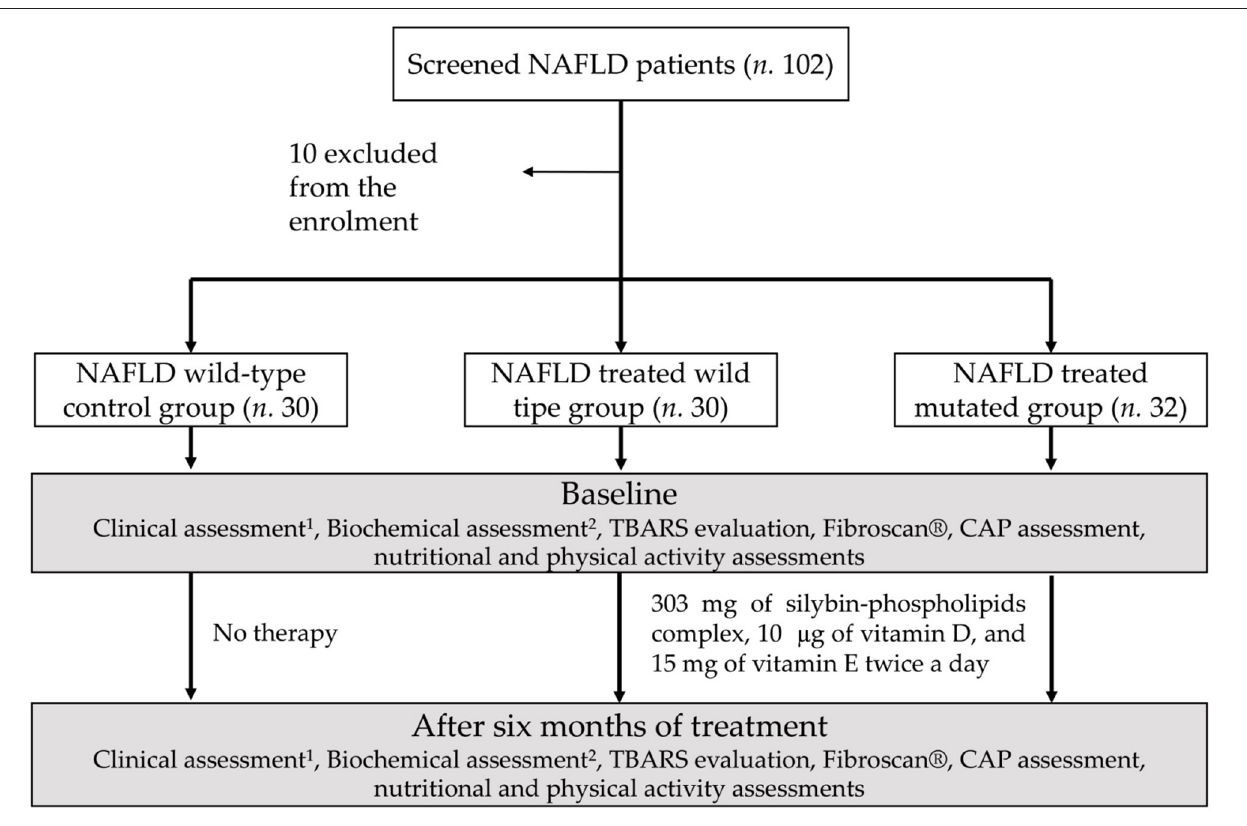
FIGURE 1 | Study design diagram flowchart: schematic representation of the experimental paradigm performed. 1 Weight, height, and waist-to-height ratio, body mass index, blood pressure measurement, BMI. 2 Blood glucose and insulin, HOMA-IR, aspartate and alanine aminotransferases, gammaglutamyltranspeptidase, blood count, C-reactive